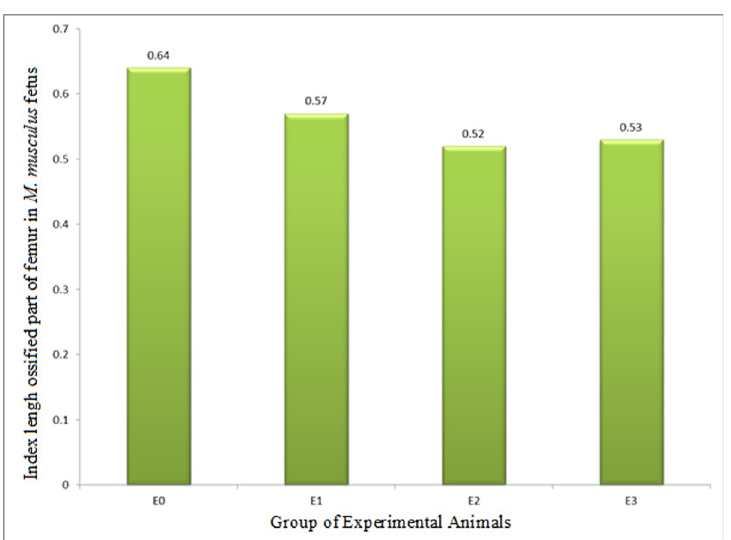
Fig 8. Index of length of ossified part (growth in length, ILOP) of femur in M . musculus fetuses on gestation day (GD) 18 which previously were given 0.39 mg/g bw LE3H through gavage on GD 10 (E1), injected with 5 mg/kg bw HgCl 2 on GD 9 (E2), and administered 5 mg/kg bw HgCl 2 on GD 9 and then 0.39 mg/g bw LE3H on GD 10 (E3). Meanwhile, the controls (E0) were administered double-distilled water